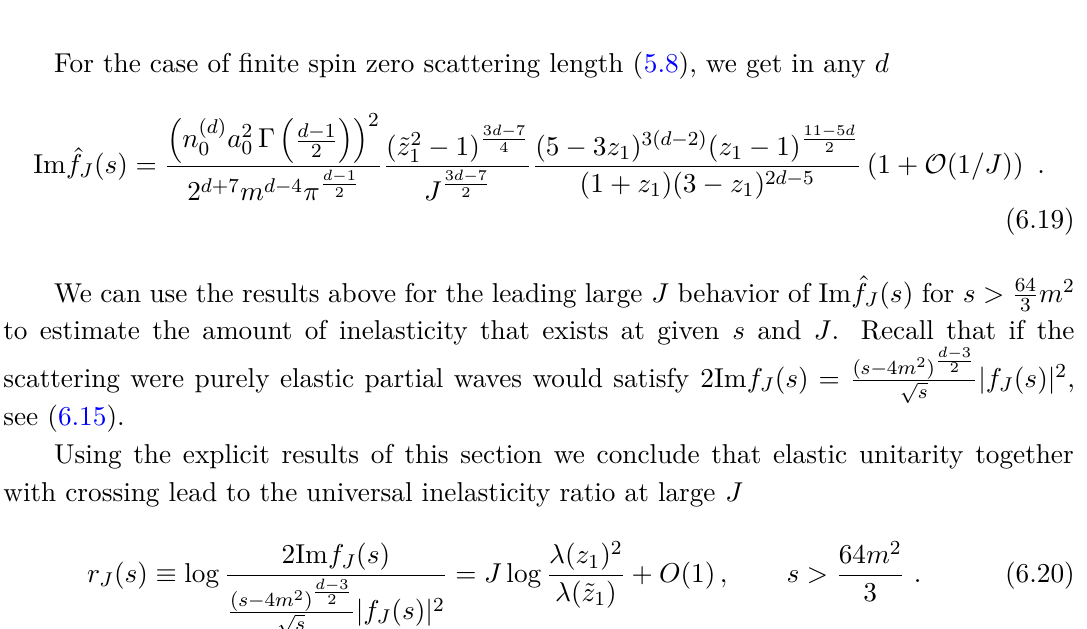
Figure 11 . The large spin inelastisity ratio r J ( s ) in (6.20) plotted for s > 64 value of the ratio is achieved at s = 40 m 2 for which we get r J (40 m 2 ) ’ 0 . 473 J (1 + O (1 /J ))